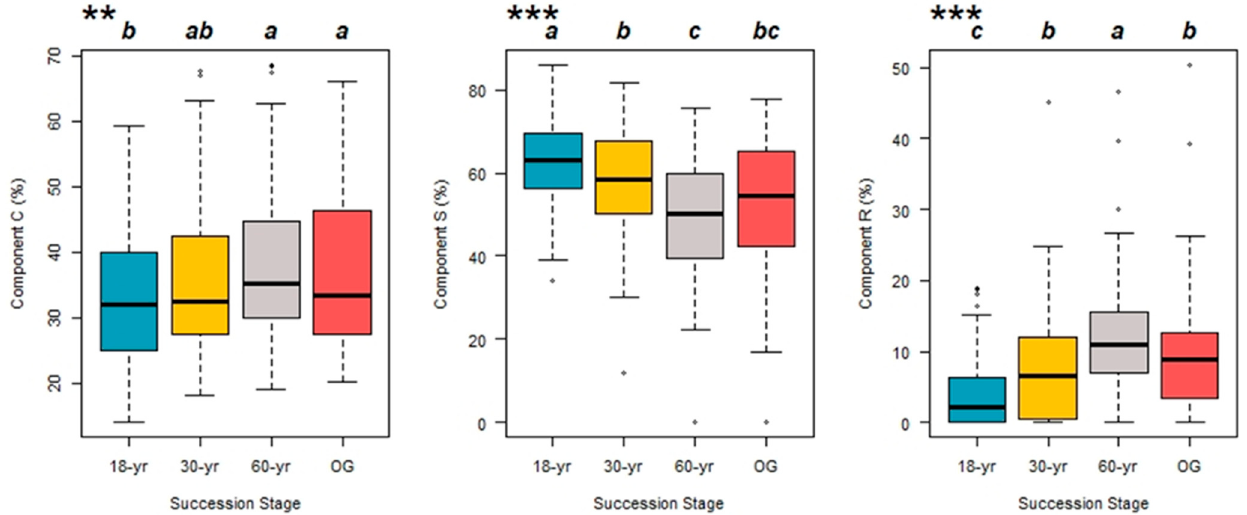
Figure 3. Changes in CSR ecological strategy values of co-existing tree species in different succession stages of tropical lowland rain forests in Hainan. The box represents the strategy values of 13 species. (Blue, 18-year-old forest; yellow, 30-year-old forest; gray, 60-year-old forest; red, old-growth forest.) One-way ANOVA test **, p < 0.01, ***, p < 0.001 indicates significant difference. A post hoc Tukey test was performed to test difference of combinations within each component: different letters indicate significant difference among successional stages ( p < 0.05).